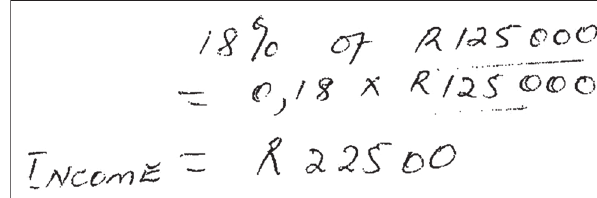
FIGURE 6: Response of ZON 090 to Task